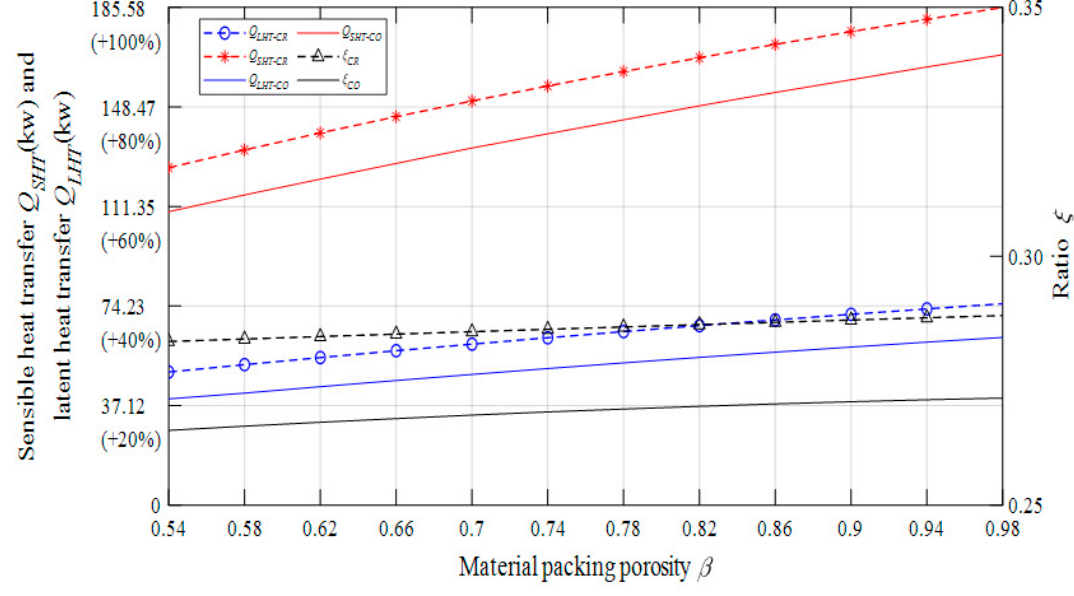
Figure 18. Influence of material packing porosity on energy transfer characteristics.